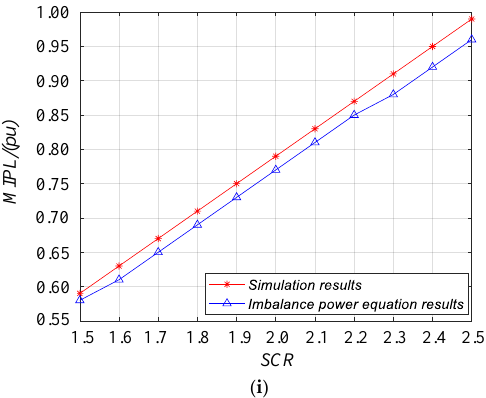
Figure 9. The simulation results when the remote voltage sag occurs: ( a ) The system is critically stable ( P in = 0.754 pu, SCR = 1.9, k vp = 6 ); ( b ) The system is unstable ( P in = 0.755 pu, SCR = 1.9, k vp = 6 ); ( c ) The system is critically stable ( P in = 0.794 pu, SCR = 2.0, k vp = 6 ); ( d ) The system is unstable ( P in = 0.795 pu, SCR = 2.0, k vp = 6 ); ( e ) The system is critically stable ( P in = 0.795 pu, SCR = 2.0, k vp = 7 ); ( f ) The system is unstable ( P in = 0.796 pu, SCR = 2.0, k vp = 7 ); ( g ) The system is critically stable ( P in = 0.796 pu, SCR = 2.0, k vp = 9 ); ( h ) The system is unstable ( P in = 0.797 pu, SCR = 2.0, k vp = 9 ); ( i ) Relationship between short circuit ratio (SCR) and maximum input power limit (MIPL) when k vp = 6.